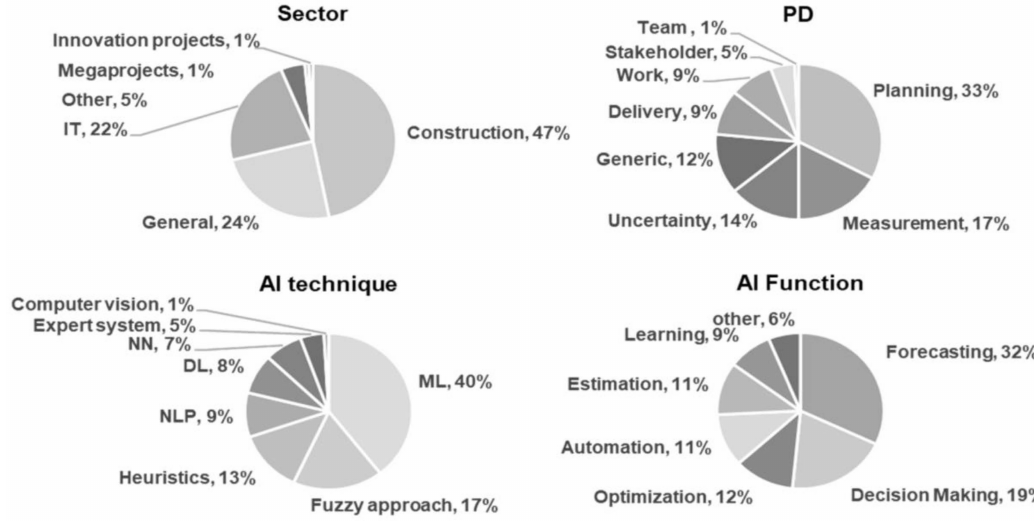
Figure 2. Content